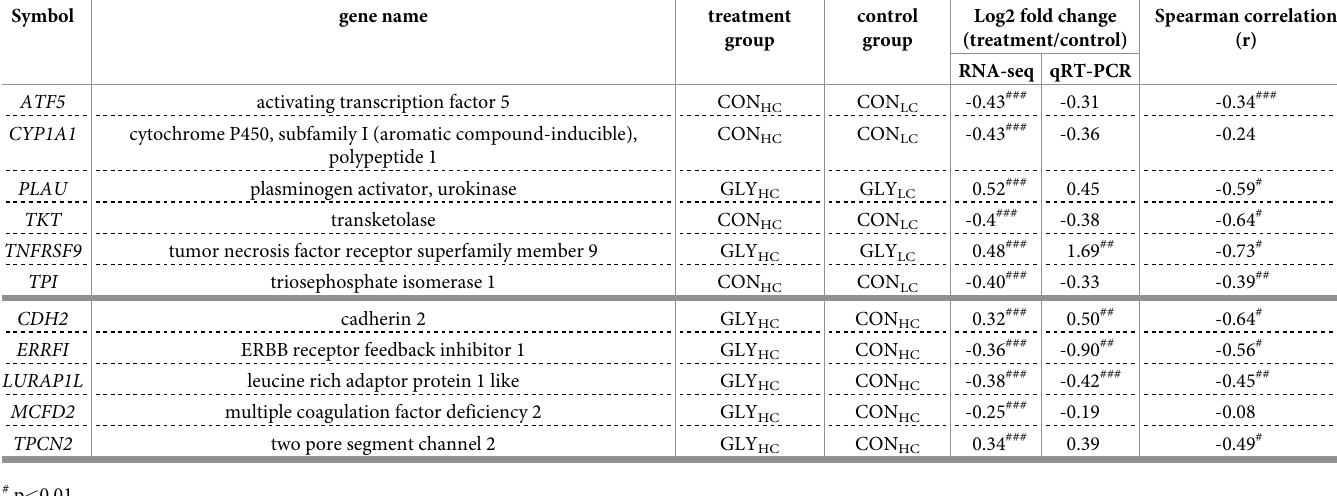
Table 3. Selected relevant differentially expressed genes analyzed in RNA-seq and validation by qRT-PCR.